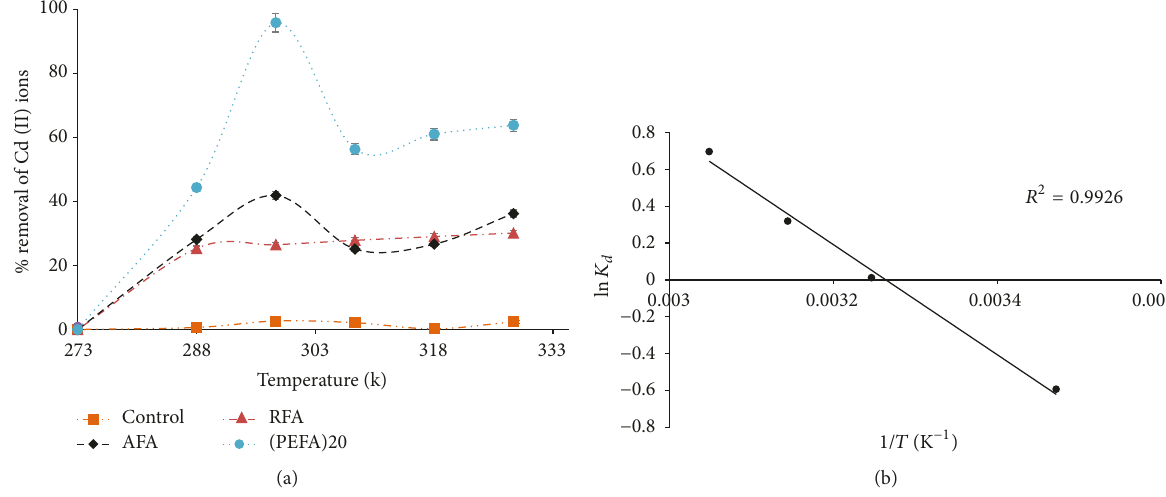
Figure 14: (a) The influence of temperature on the removal efficiency of Cd (II) ions on FA based adsorbents (RFA, AFA, and PEFA) as a function of pH value of 9, 2 mg/L metal ion concentration, 150 rpm mixing rate, contact time of 15 min, 4 g/L adsorbent dosage, and 50 mL volume of aqueous solution. (b) Van Hoff plot for Cd ion sorption at pH value of 9, 2 mg/L metal ion concentration, 150rpm mixing rate, PEFA, contact time of 15min, 4 g/L adsorbent dosage, and 50 mL volume of aqueous solution.